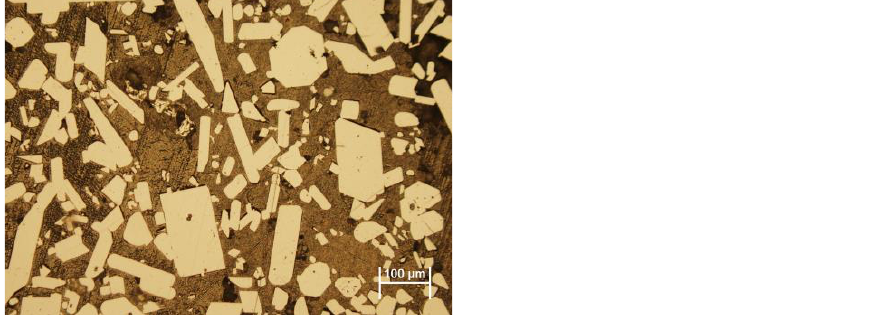
Figure 3. Microstructure of bottom zinc dross after etching (dark color represents a zinc matrix and light color objects represent intermetallic compounds of FeZn 13 ).